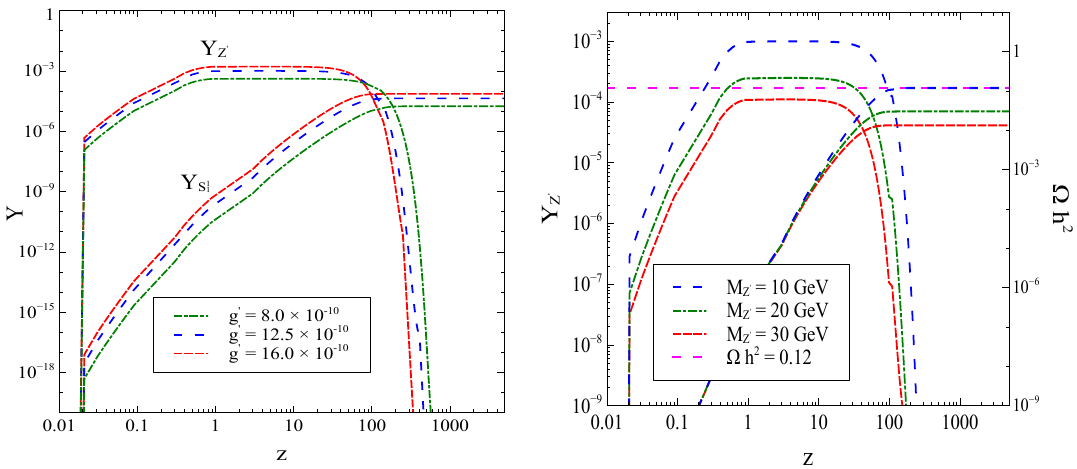
(for the decay 1 = 10 keV, M h = 1 TeV, S 1 1 2